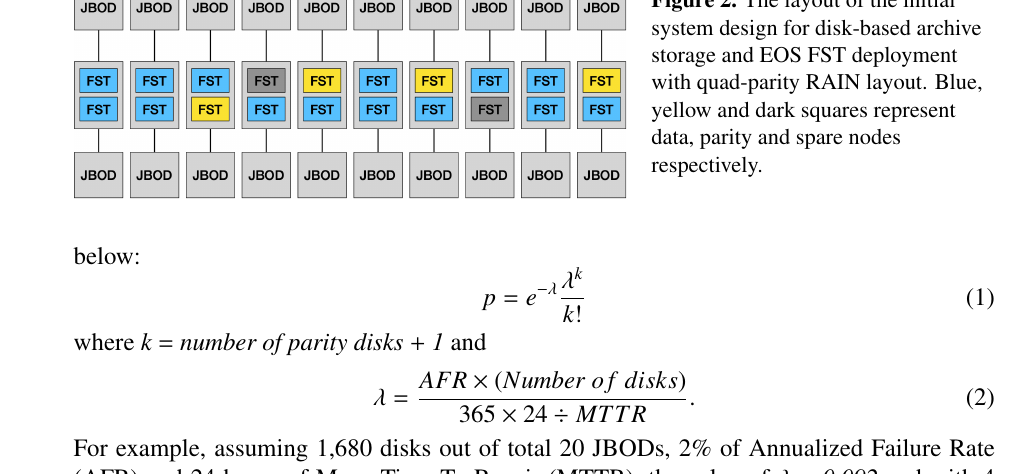
Figure 2. The layout of the initial system design for disk-based archive storage and EOS FST deployment with quad-parity RAIN layout. Blue, yellow and dark squares represent data, parity and spare nodes